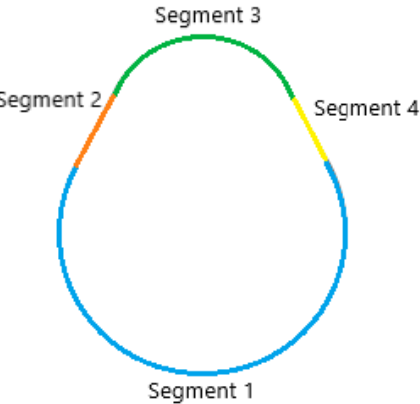
Figure9. Segmentsintowhichthemeasuredcamprofileshavebeendividedinthemeasurementprocess. Figure 9. Segments into which the measured cam profiles have been divided in the measurement process. This division of the measured profile in sections might introduce some geometrical